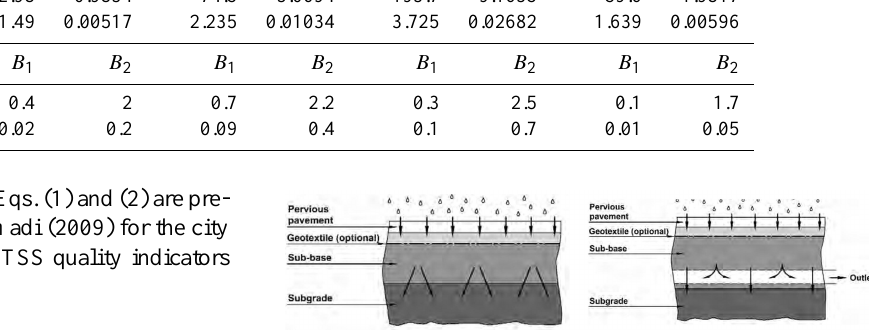
Table 1. Build-up and wash-off parameters (Tajrishi and Malekmohammadi, 2009). Equation Low density High Density Industrial Other of pollution